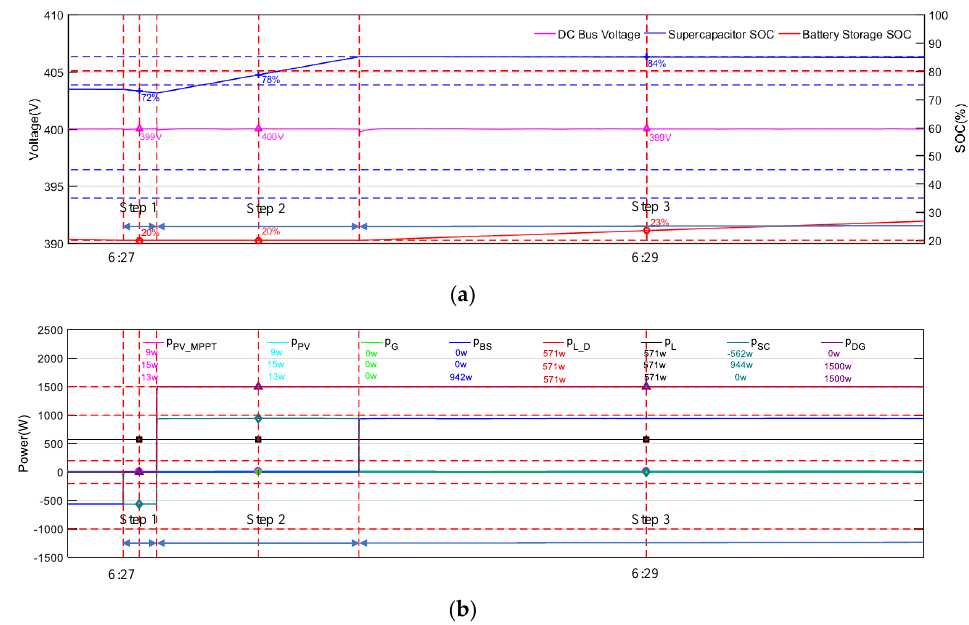
Figure 11. Curves of common DC Bus voltage and SOC of storage ( a ) and curves of power ( b ) when